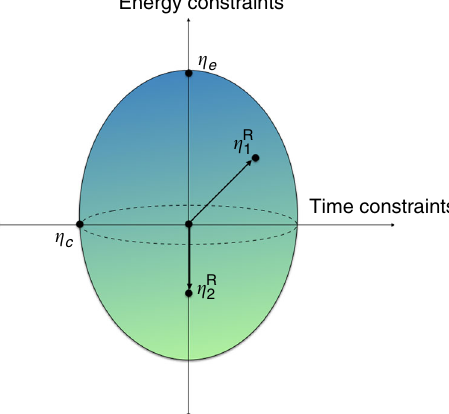
Fig. 2 Time-energy constraints for thermal processes. The entropic conditions for a state transformation ρ A ! σ A ′ under TPs are de fi ned with respect to a quantum reference frame R and two states η R schematic vertical axis denotes states block-diagonal in energy (e.g., an energy eigenstate η e ¼ j E ih E j ), while the horizontal axis denotes states with maximal time-dependent oscillations —‘ clock ’ states η C of R . When η R con fi ned to being incoherent (the vertical axis) we recover thermo- majorization. For R being macroscopic and η R Page – Wootters clock constraint on the thermodynamic transformation. Varying η R smoothly interpolates between the time constraints and energy 1